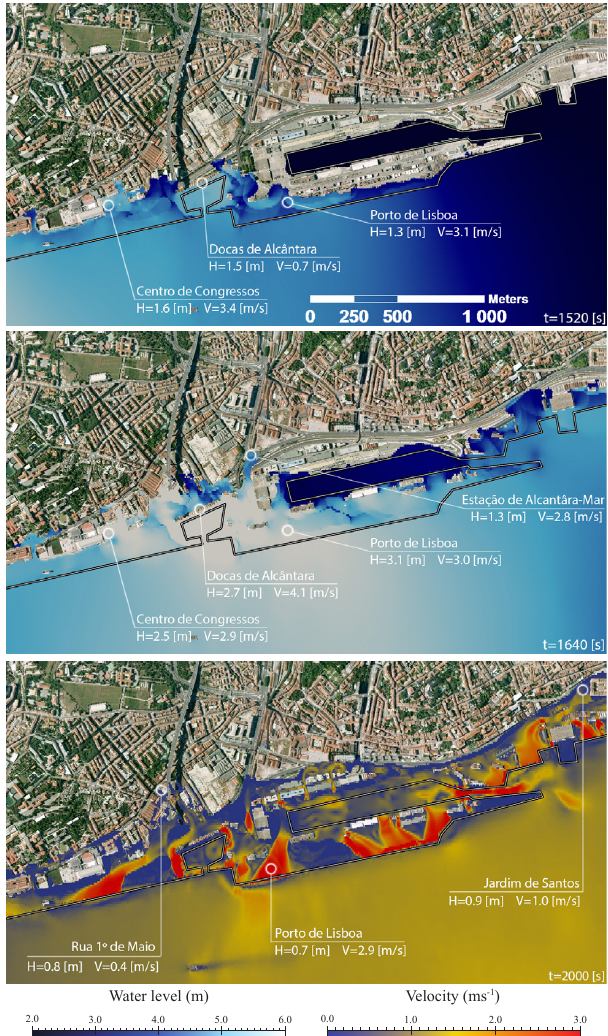
Fig. 10. Results for Alcântara. Water level at 12min (top) and 14min (center); velocities at 20min (draw-down, Fig. 10: Results for Alcantara. Water level at 12 (Top) and 14 min (center); velocities at 20 min (Draw-down, bottom)